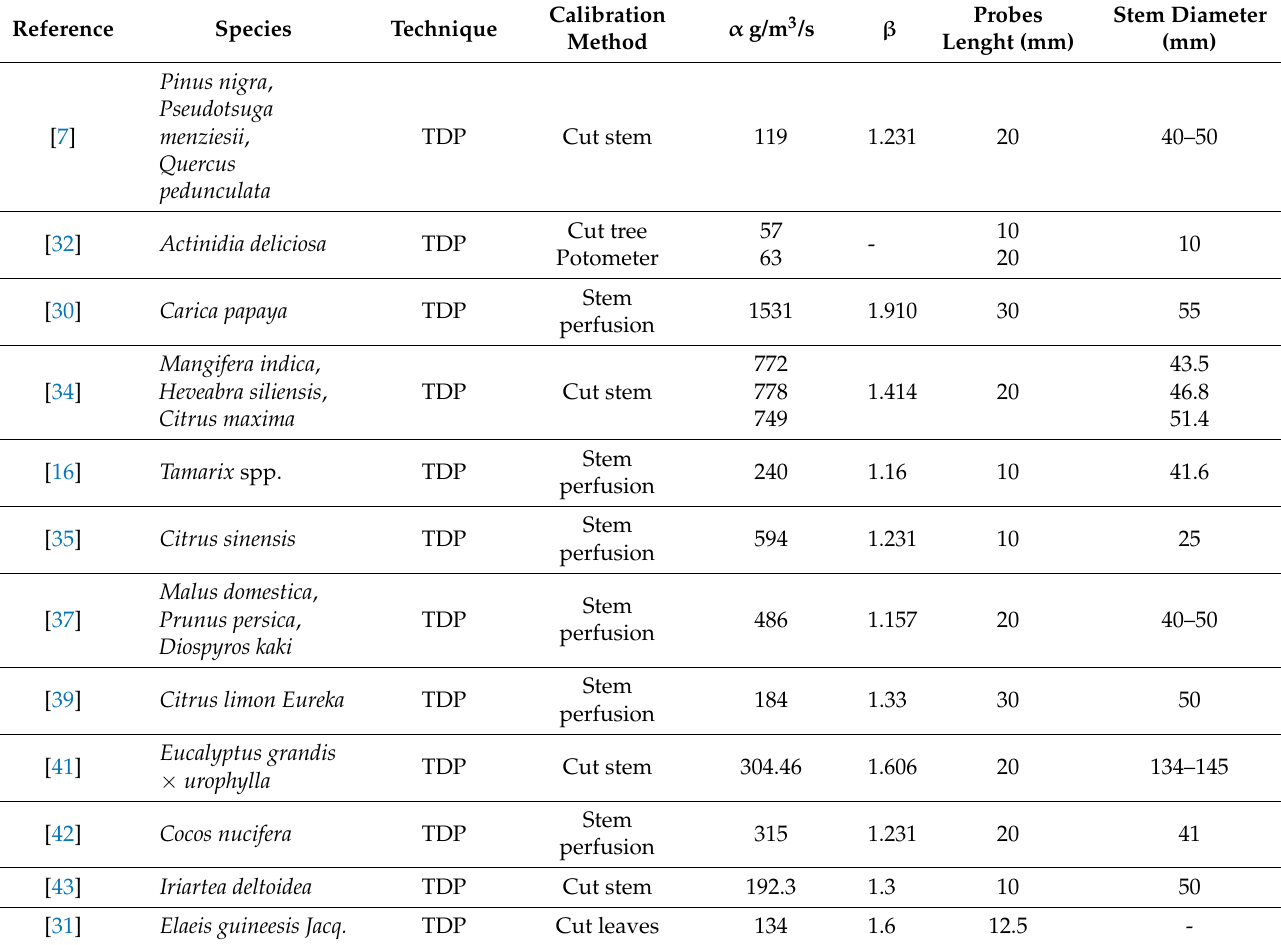
Table 3. Examples of the calibration of sap flow systems using thermal dissipation method